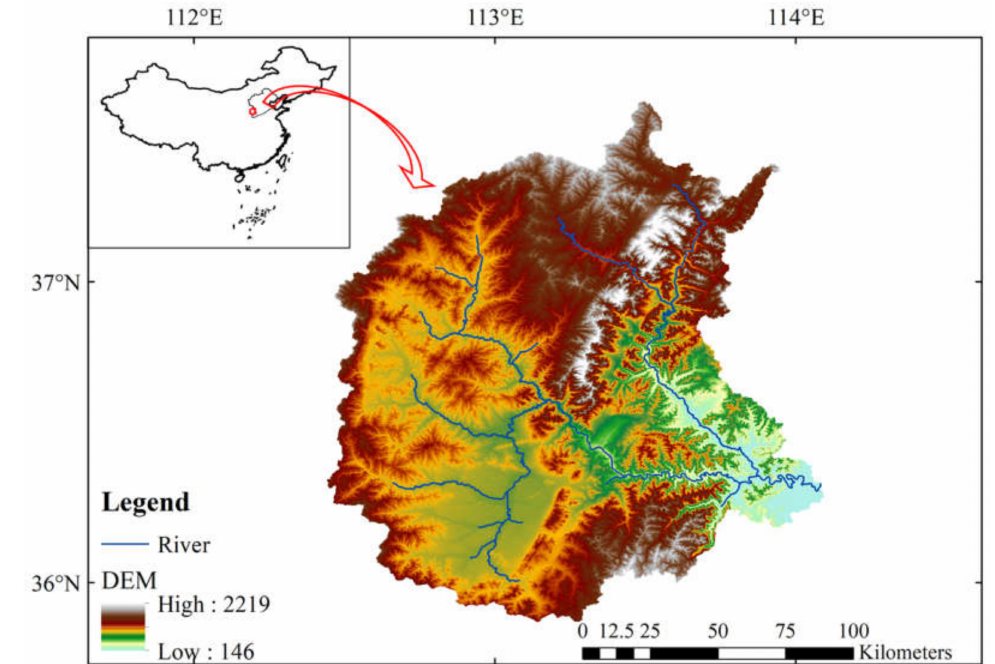
Figure 1. Location map of the study